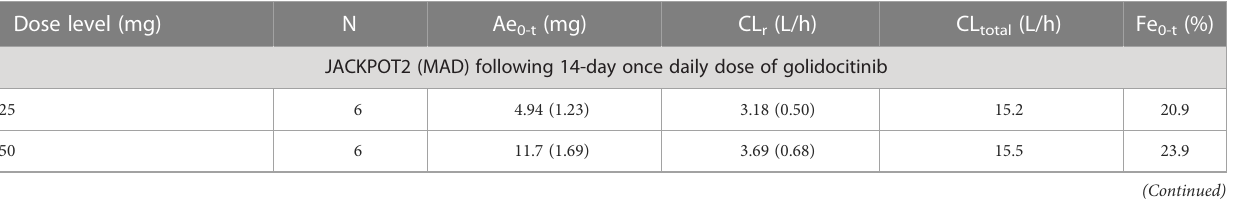
TABLE 2B Urinary PK parameters of